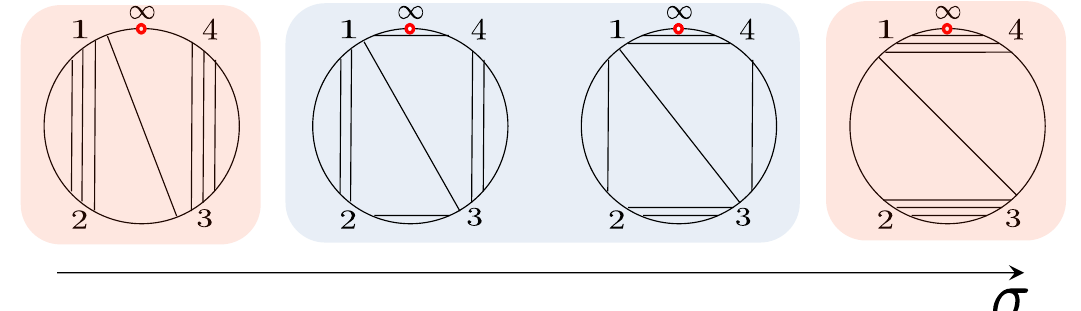
Figure 10 . The one-dimensional \moduli space" of the diagrams for L 1 = L 3 = 4 ; L 2 = L 4 = 3. The ones drawn on the red background correspond to the boundaries of the moduli space while the ones drawn on the blue background correspond to the bulk of the moduli